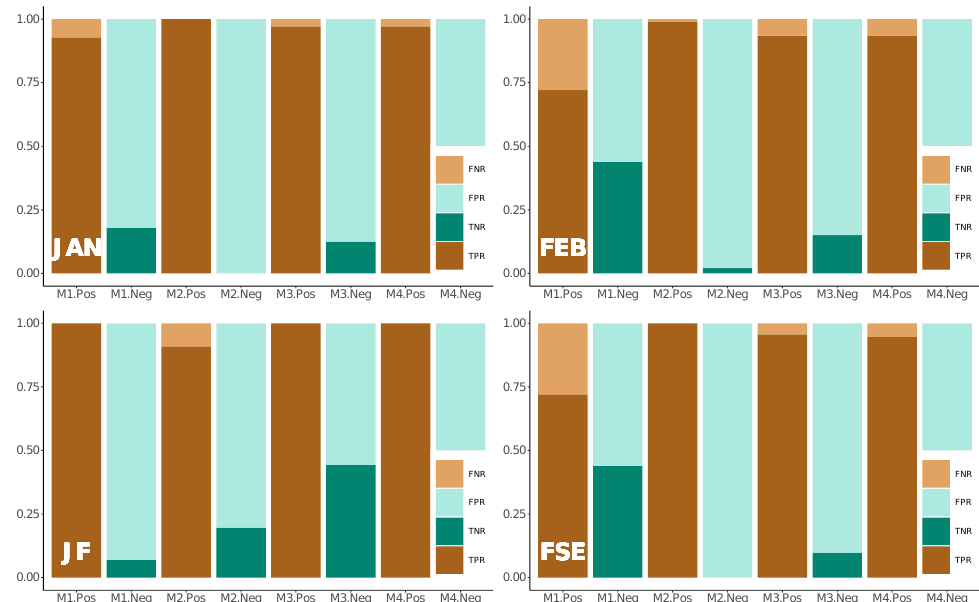
Figure 13. TPR, TNR, FPR and FNR values calculated for the landslide susceptibility maps in the zoom areas 1 (dataset JAN) and 2 (datasets FEB, JF and FSE).